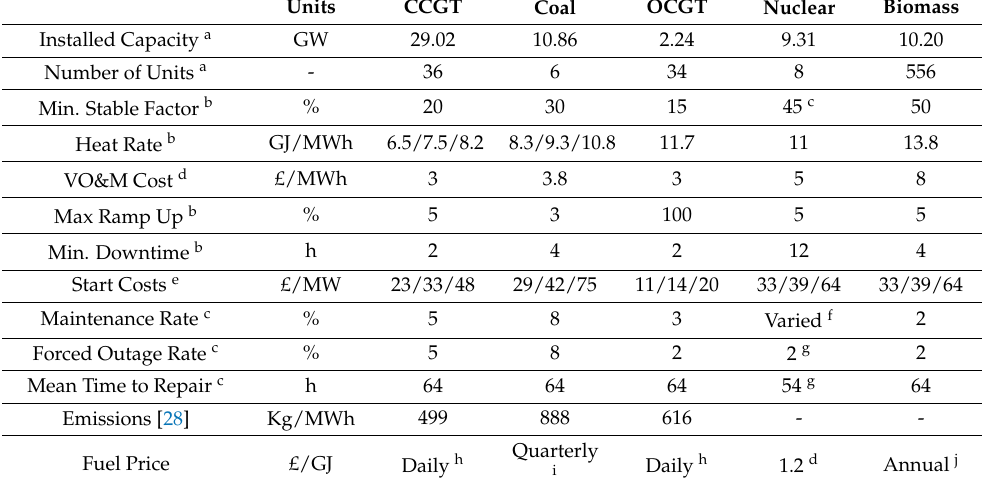
Table 1. Thermal generation techno-economic characteristics used in the model, with the source given in the first column unless otherwise noted in each cell. Heat rates and start costs are given in bands of cold/warm/hot.